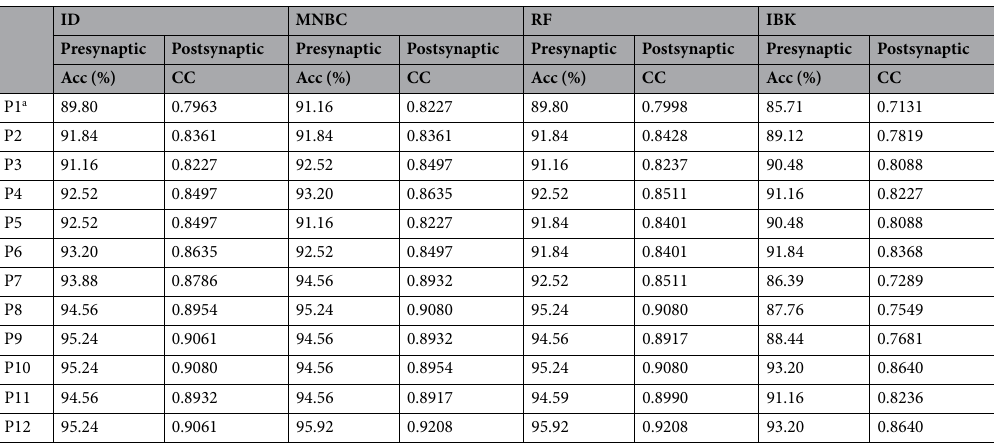
Table 2. Overall predictive accuracy and CC values obtained by ID, MNBC, RF and IBK in identifying presynaptic and postsynaptic neurotoxins with 12 parameters. a Come from 30 by using Increment of Diversity